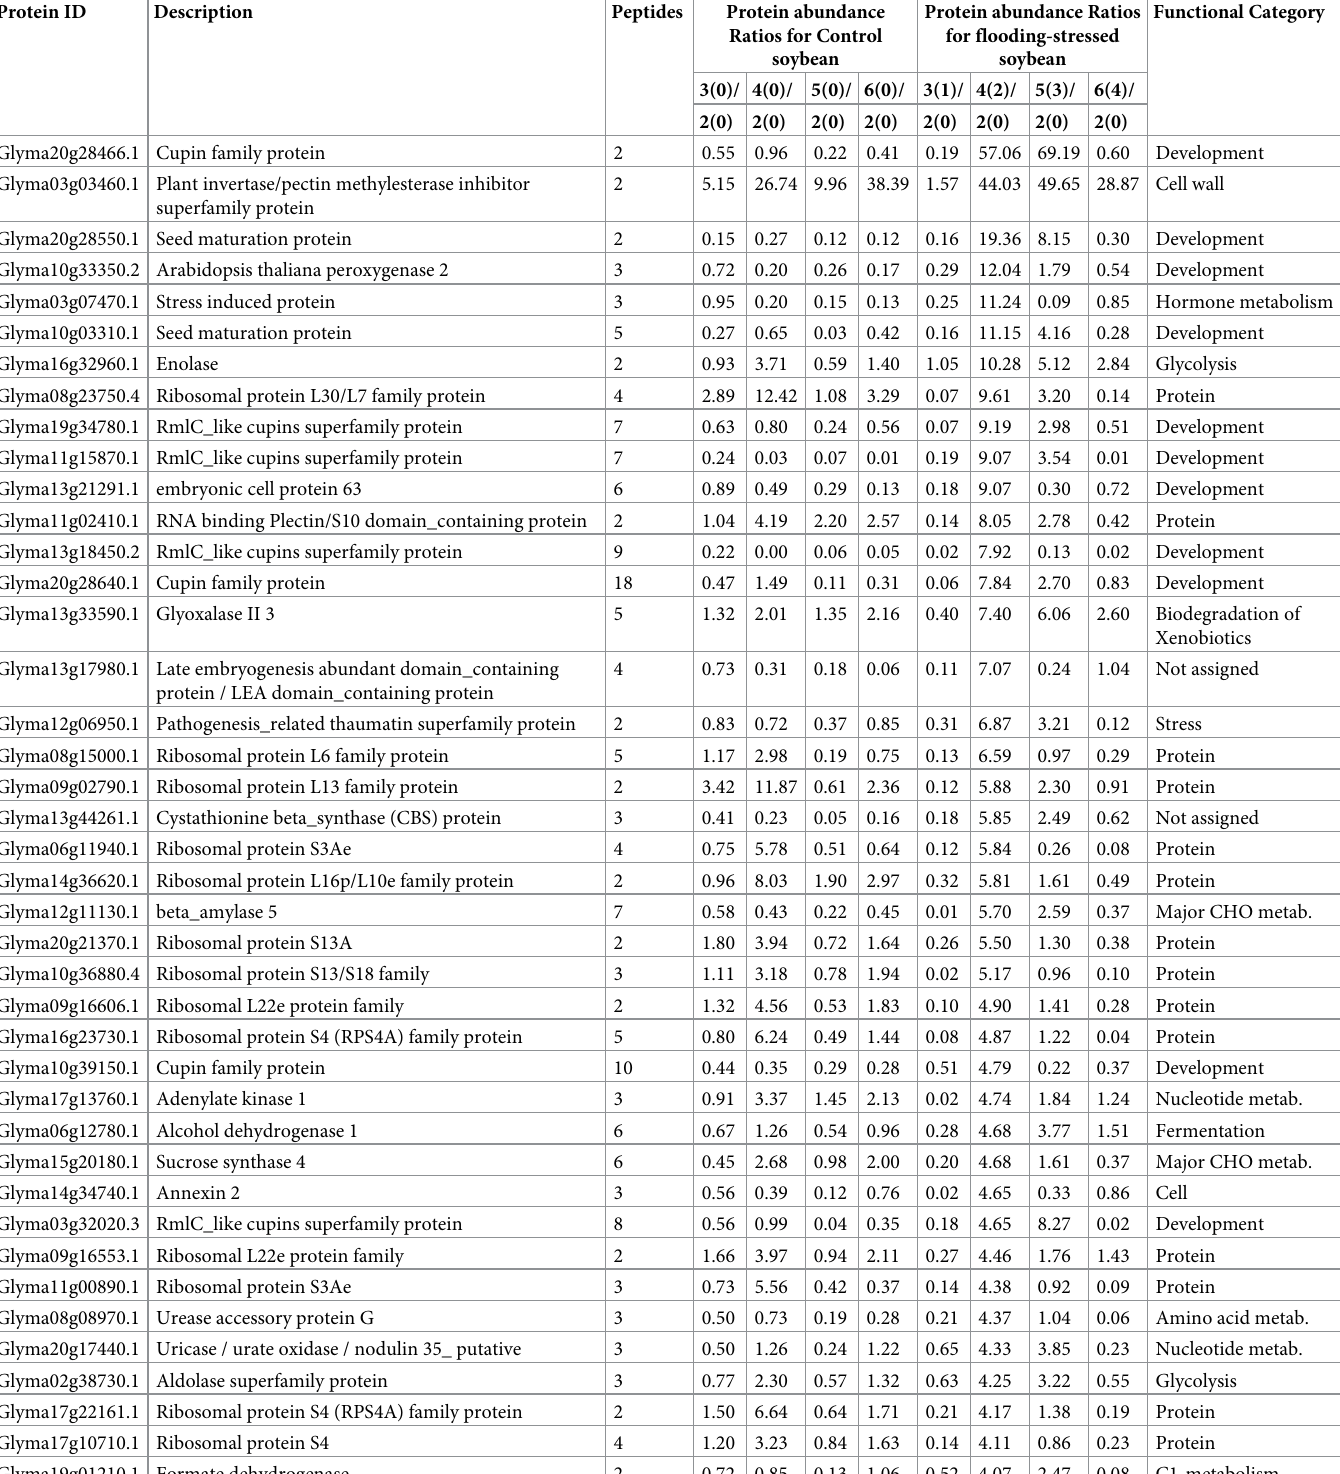
Table 1. Proteins identified in soybean that changed 4-folds in abundance after 2 days flooding as compared to starting point 2(0) �